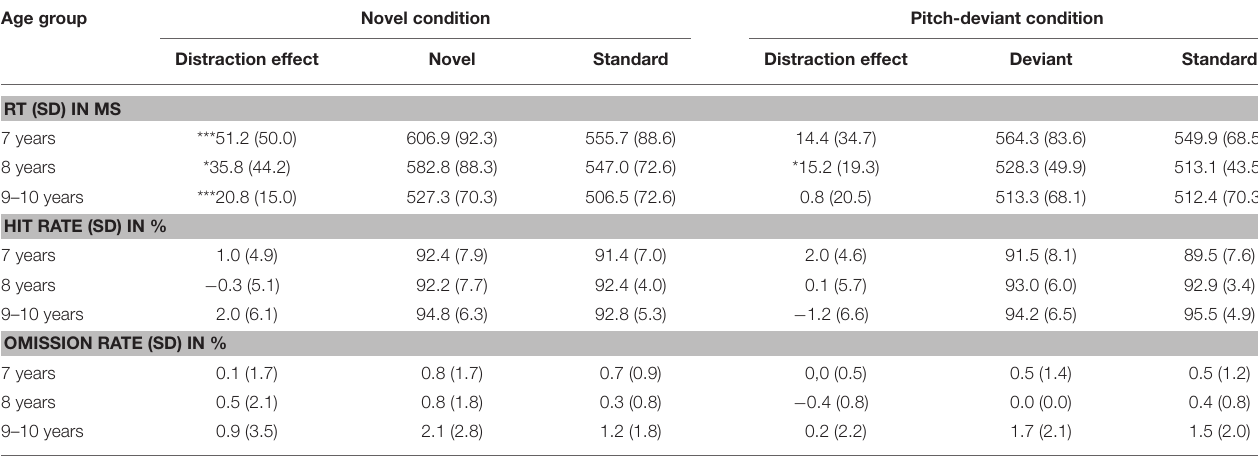
TABLE 1 | Mean reaction times (RT), hit and omission rate in % and standard deviation (SD). Age group Novel condition Pitch-deviant condition Distraction effect Novel Standard Distraction effect Deviant